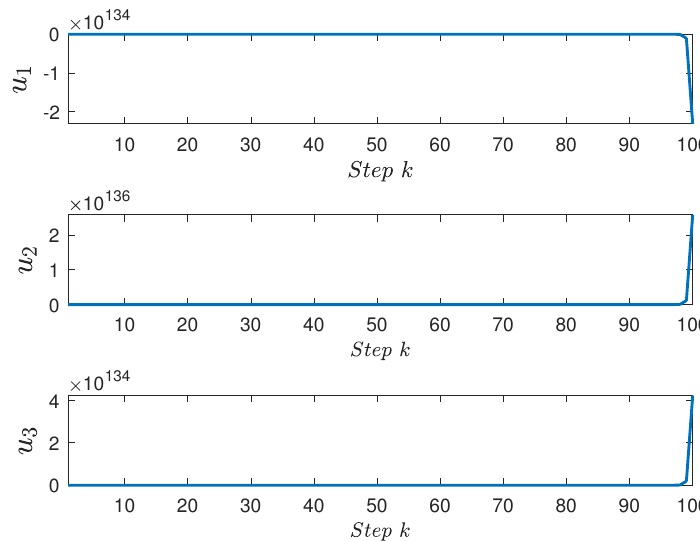
Figure 8. Control inputs of LQR.